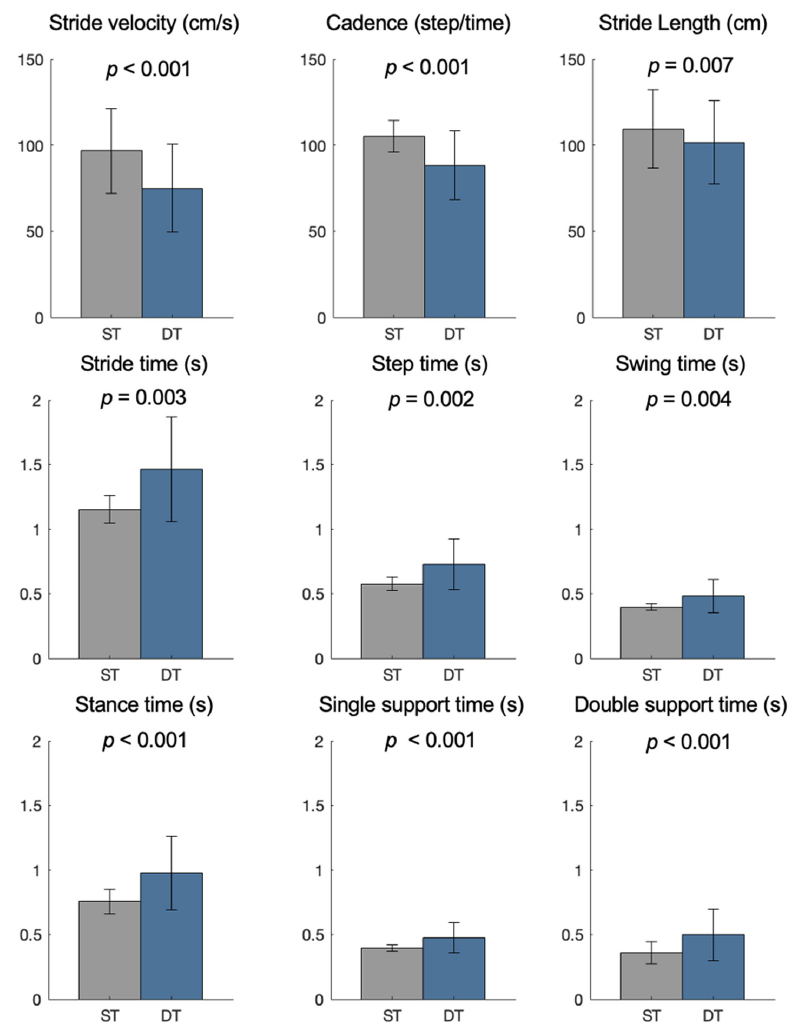
Figure 2. Spatial and temporal gait parameters measured by pressure-sensing insoles in the single- task (ST) and dual-task condition (DT).